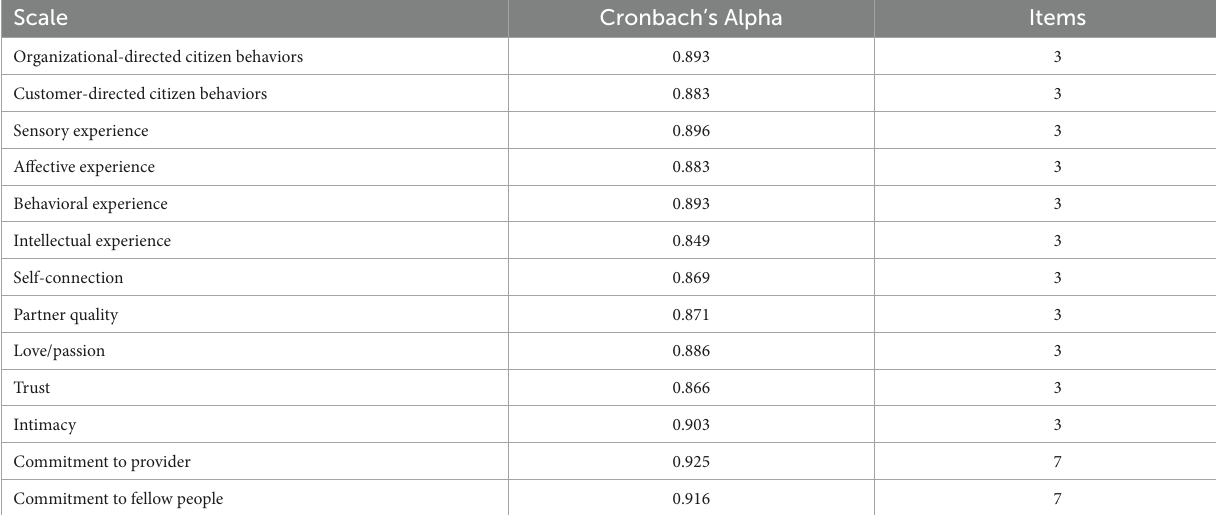
TABLE 2 Reliability